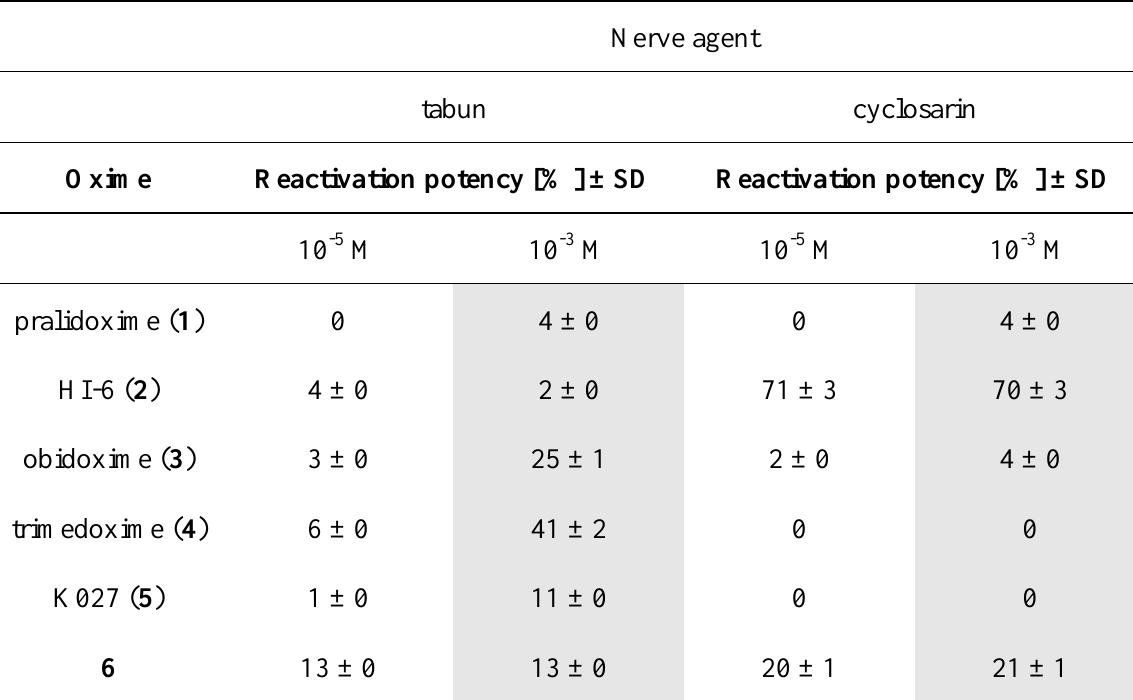
Table 1. In vitro screening results (reactivation of tabun and cyclosarin inhibited acetylcholinesterase; source of the enzyme – rat brain acetylcholinesterase; nerve agents used – tabun and cyclosarin; time of inhibition by nerve agent – 10 min; time of reactivation – 30 min; pH 7.6; 25